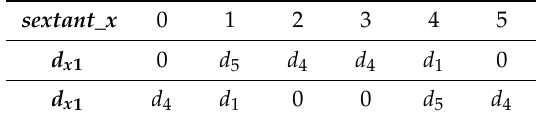
Table 4. Leg duty ratios of Levels 1 and 4 depending on the